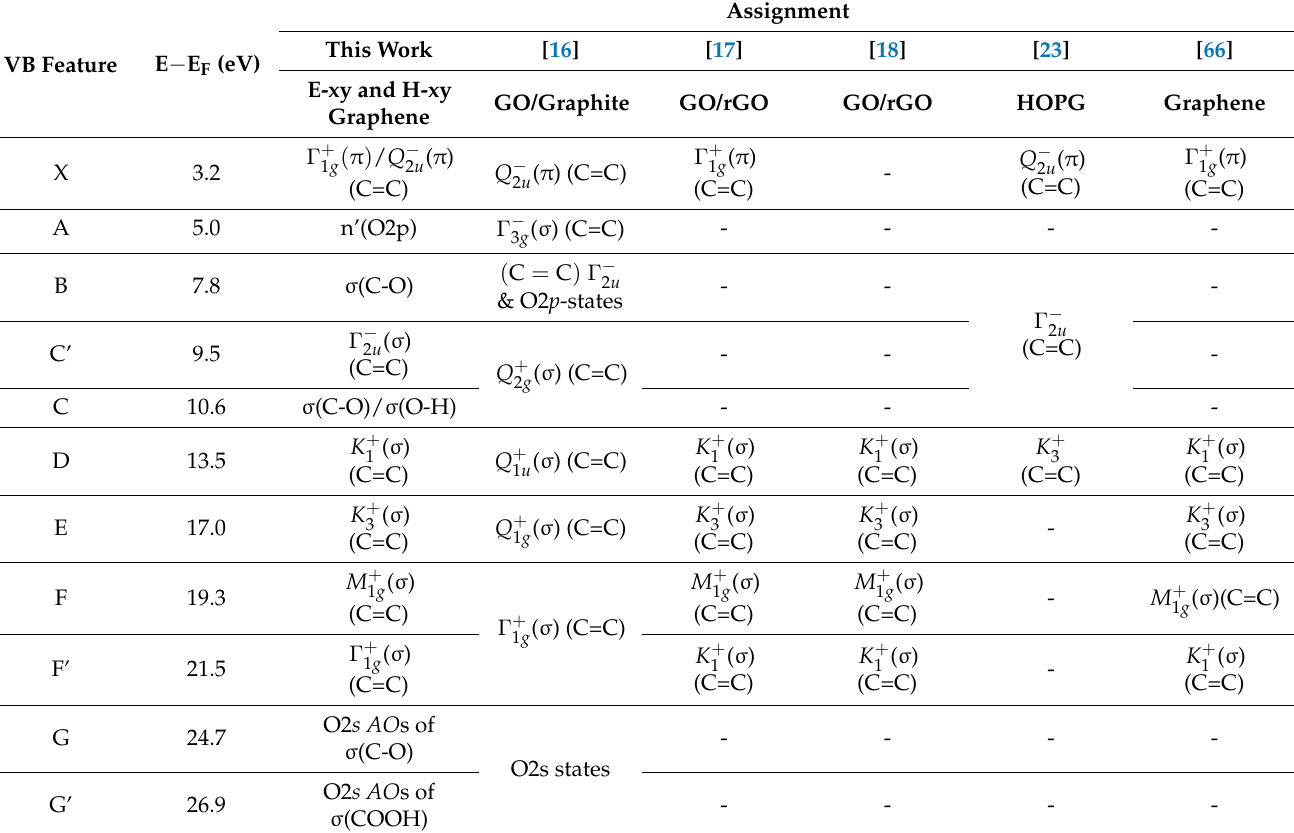
Table 2. Comparison of the VB feature assignments for the studied graphene